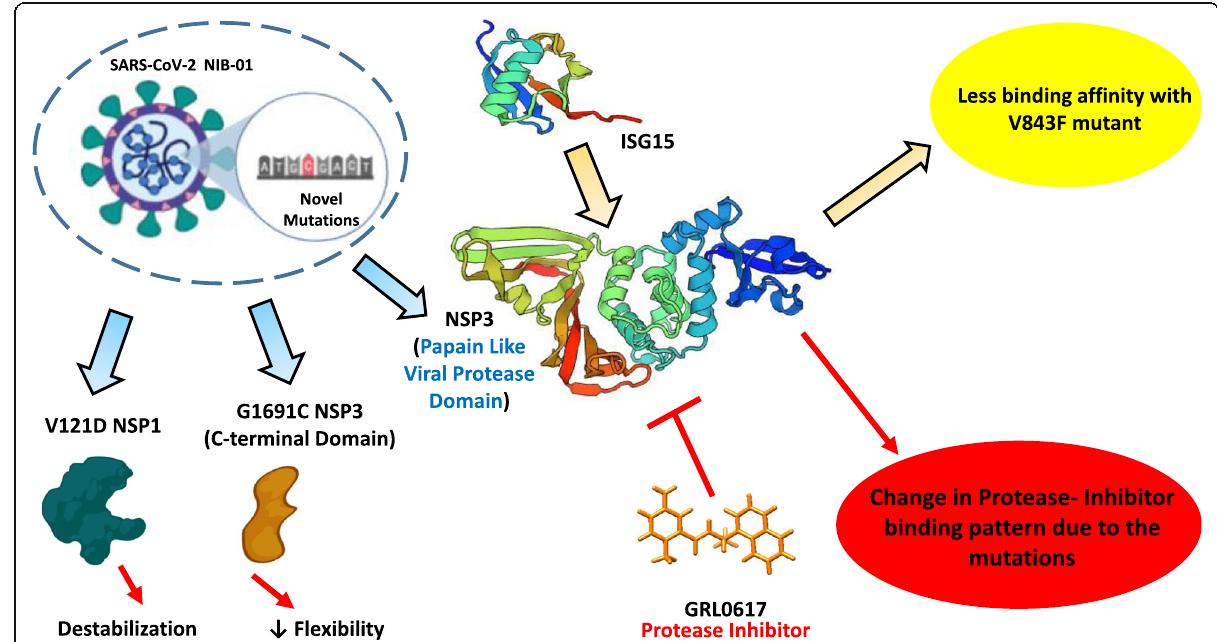
Fig. 1 Graphical representation of the whole work. Some of the parts of this figure were generated with the help of BioRender